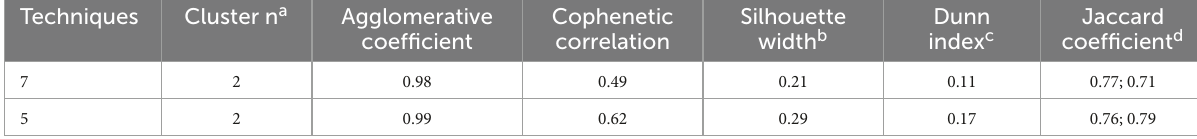
TABLE 5 Hierarchical cluster analysis fit and stability indices. Techniques